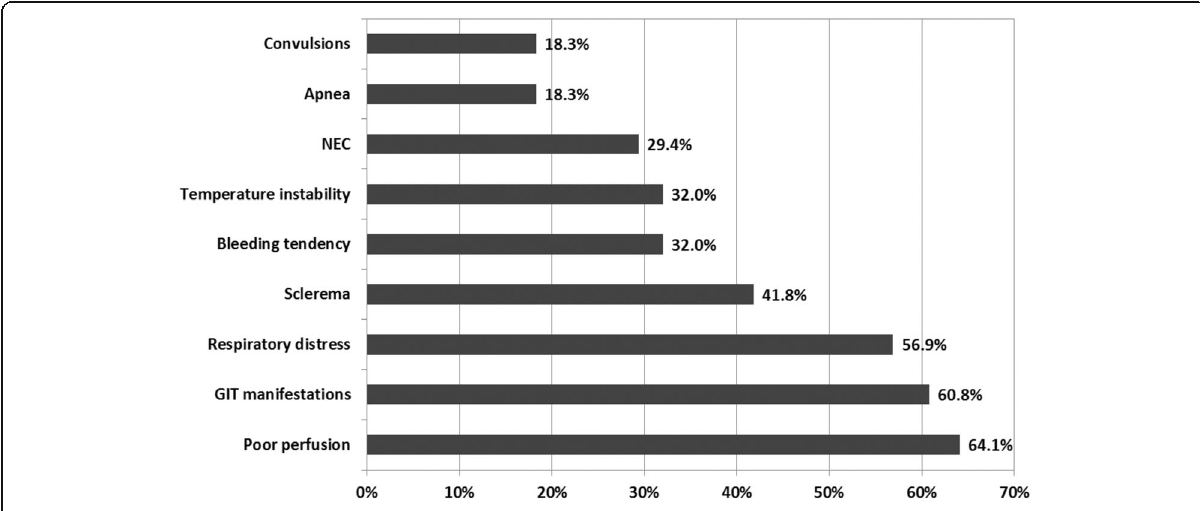
Fig. 1 Clinical picture of sepsis in the studied neonates